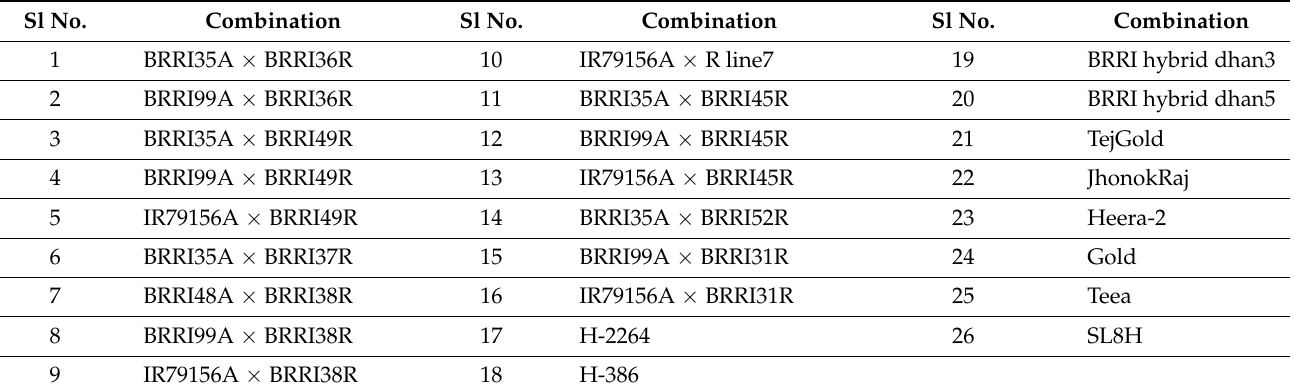
Table 12. List of 26 rice hybrid